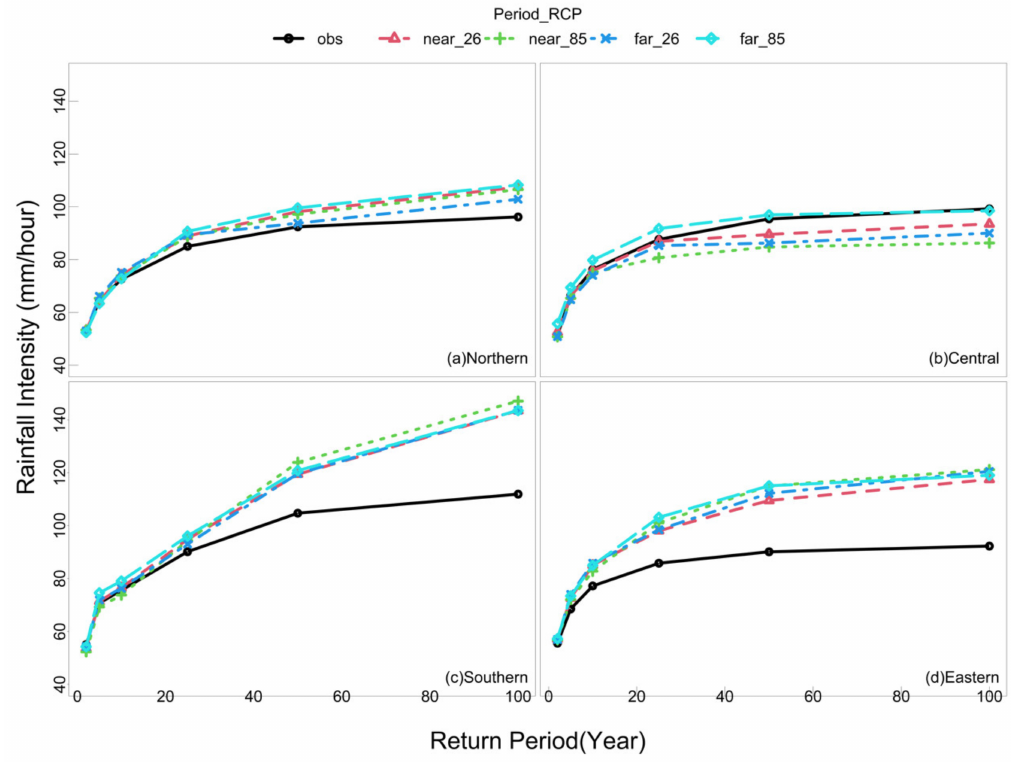
Figure 10. Rainfall intensities of the 1-h events (D1) in different return periods for the four regions and four